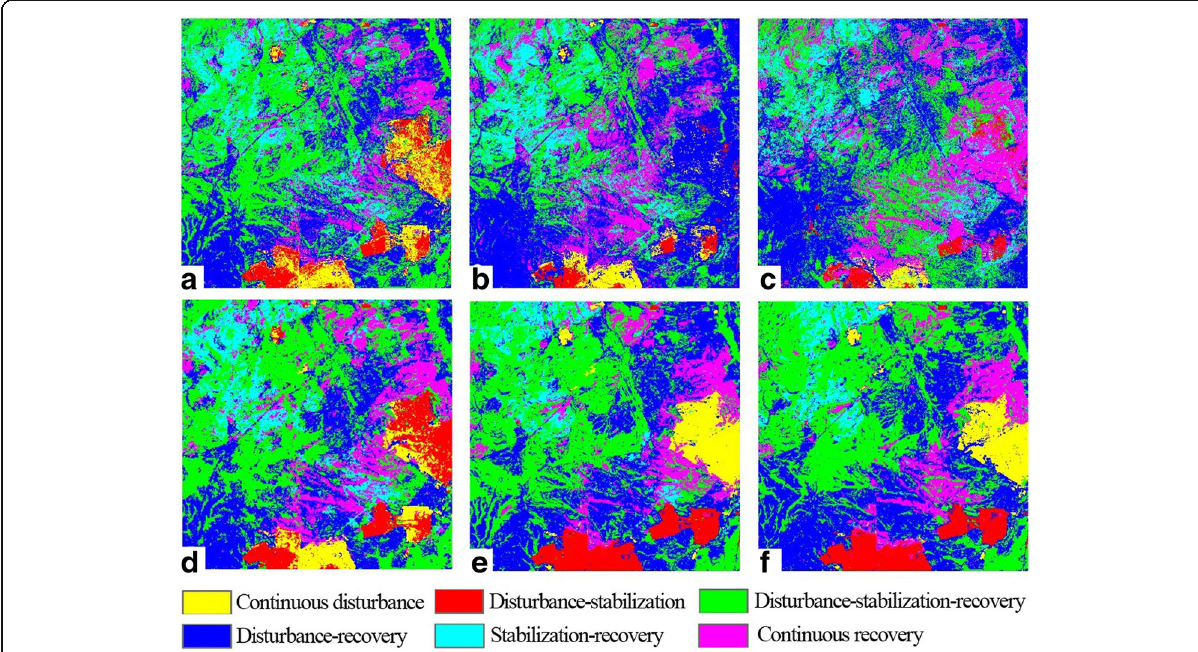
Fig. 6 Fusion of cluster information and pixel classification information. ( a ) 1NN-DTW. ( b ) Mahalanobis. ( c ) SAM. ( d ) 1NN-MRF-Semi-GDTW-FCM. ( e ) Mahalanobis-MRF-Semi-GDTW-FCM. ( f )